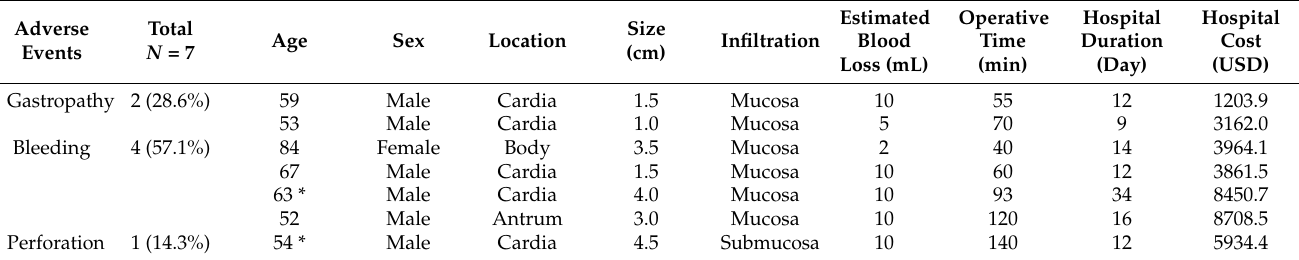
Table 3. Adverse events after ESD treatment for early gastric cancer